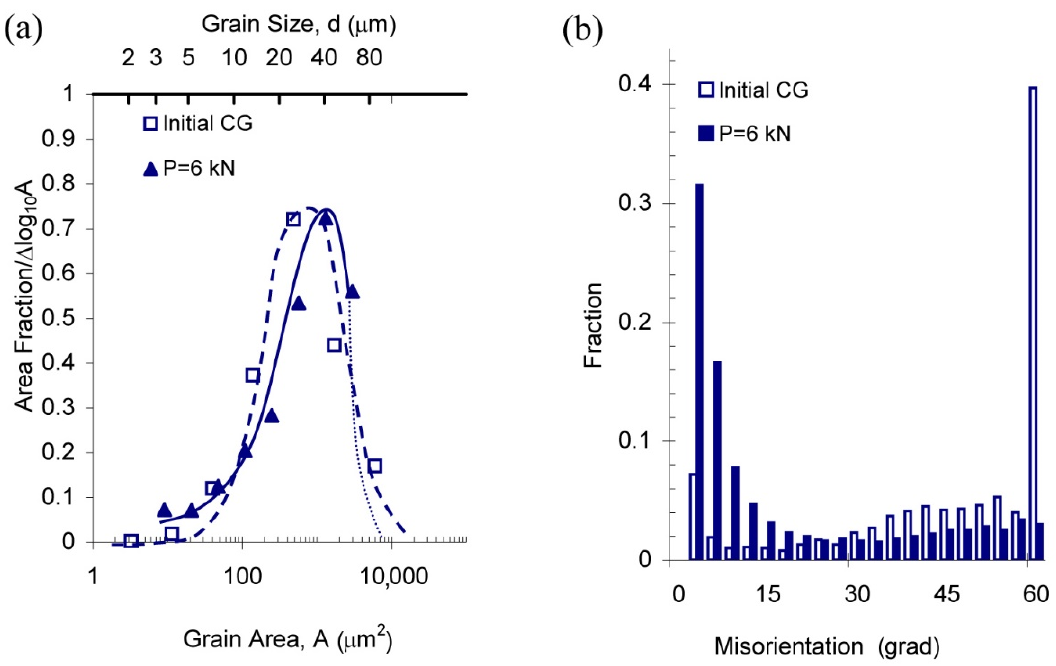
Figure 9. Typical distributions of grain sizes in the original sheet and in welded joints ( a ) and distributions of misorientation angles in welded joints made of discs with the initial CG structure ( b ).